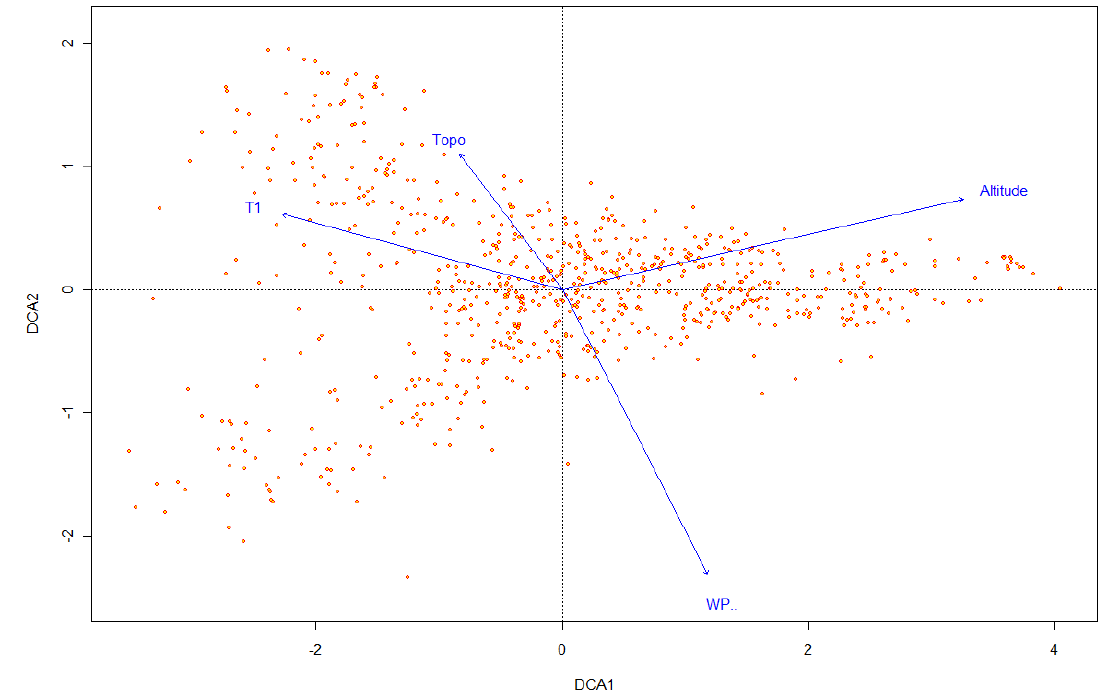
Figure 4. Distribution of relevés and environment factors in detrended correspondence analysis (DCA) (T1: temperature of January; WP: precipitation in winter; Topo: topography; Altitude: Altitude). Table 2. Correlation value of environment factors and axis in DCA.